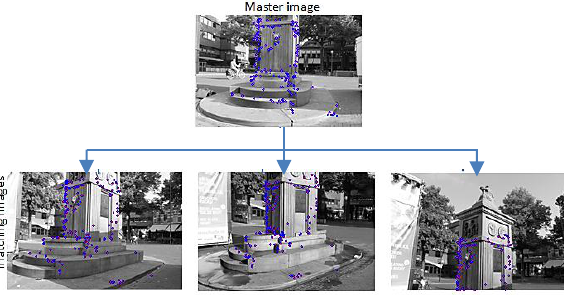
Figure 10. The four images and the matching approximation results of the guided approach The keypoints are transformed into the full size of the images and define search windows for the final SIFT matching. Fig. 11 illustrates a sample of the estimated SIFT keypoints after scaling and the windows (90*90 pixel) matching results and the final matching points after outlier removal.